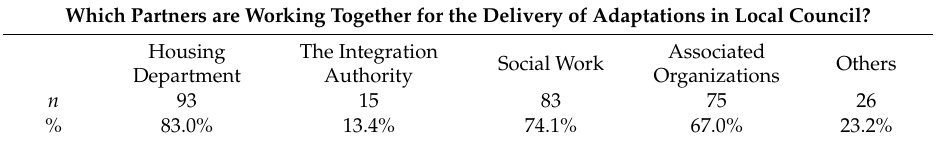
Table 1. Descriptive statistics of partnership for the delivery of adaptations within local